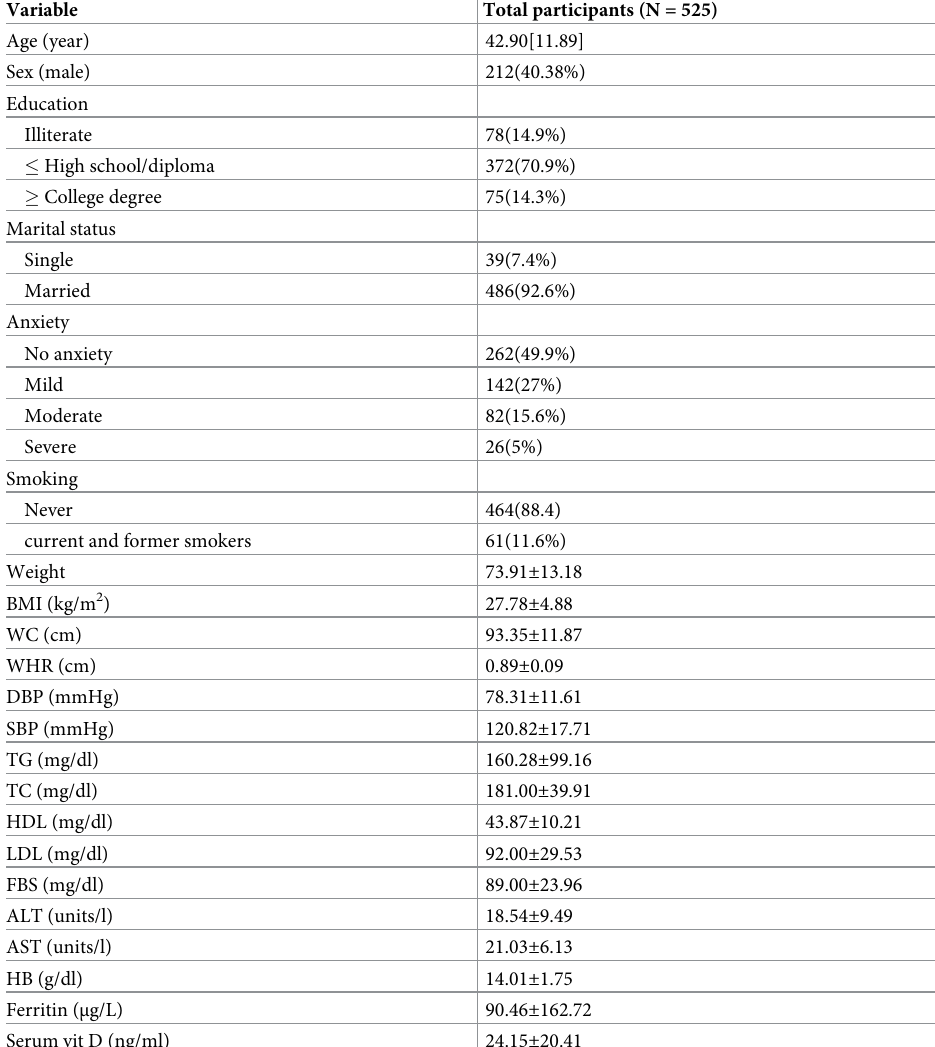
Table 3. General demographic, anthropometric and biochemical parameters in